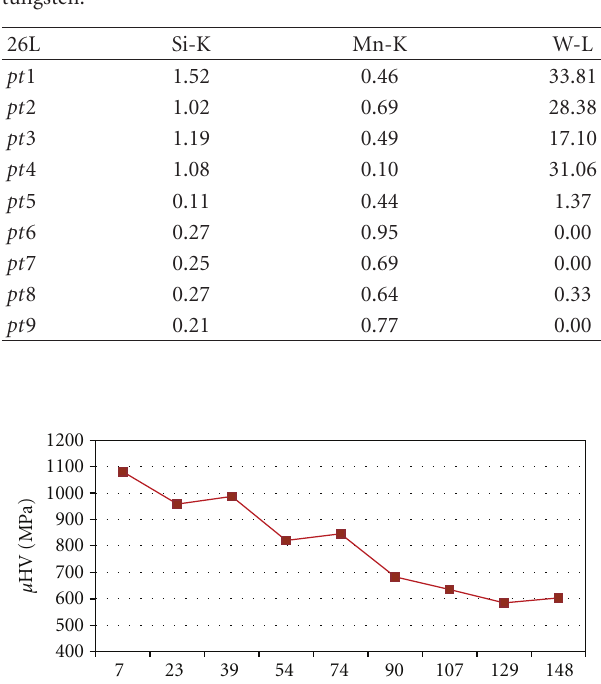
Table 3: Specification of the chemical composition investigation results for the surface layer after the tungsten electrode alloying.